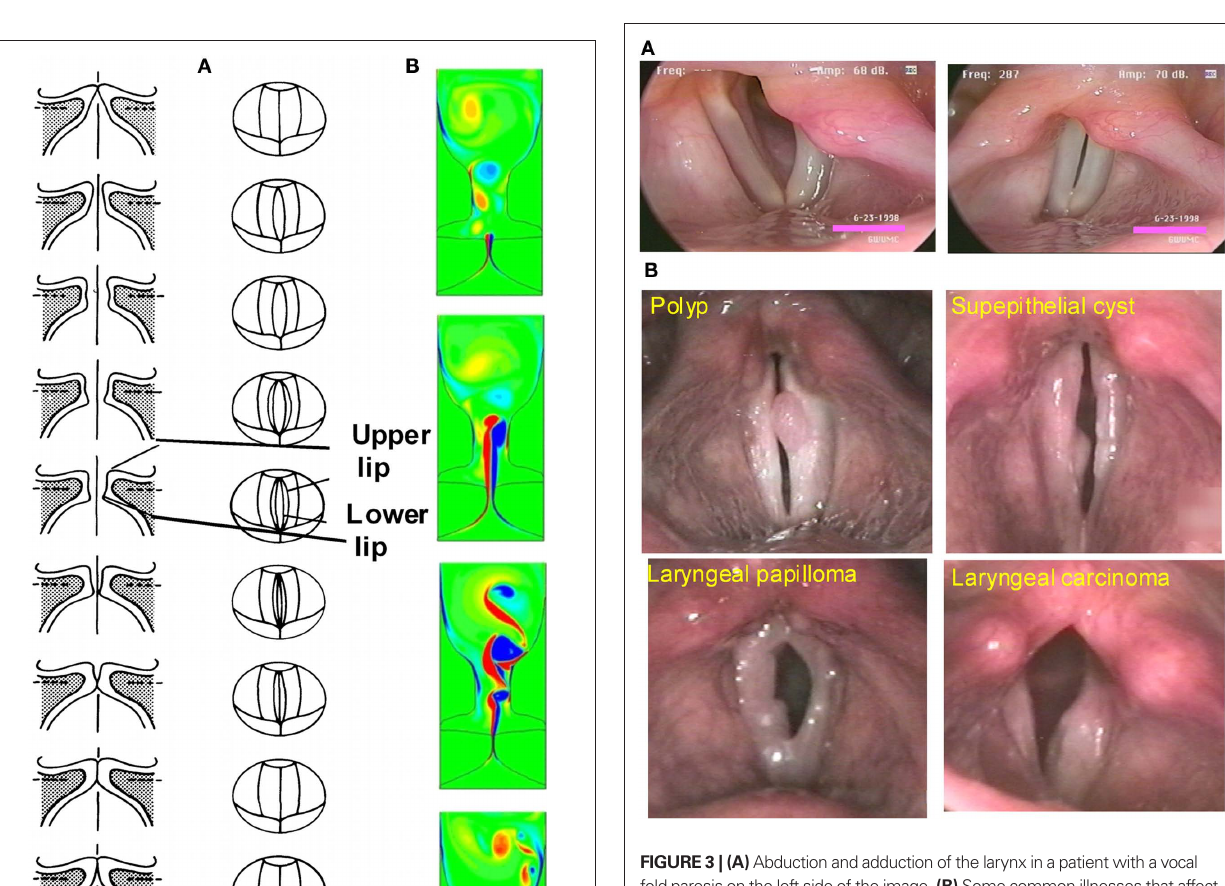
subtle differences in the mechanism of glottal incompetence. By having a more detailed understanding of the interaction of the VF mucosa with the superficial lamina propria and the underlying VF patients with glottal incompetence. One candidate for such simula- tion-assisted therapies is VFP which is often treated with a surgical